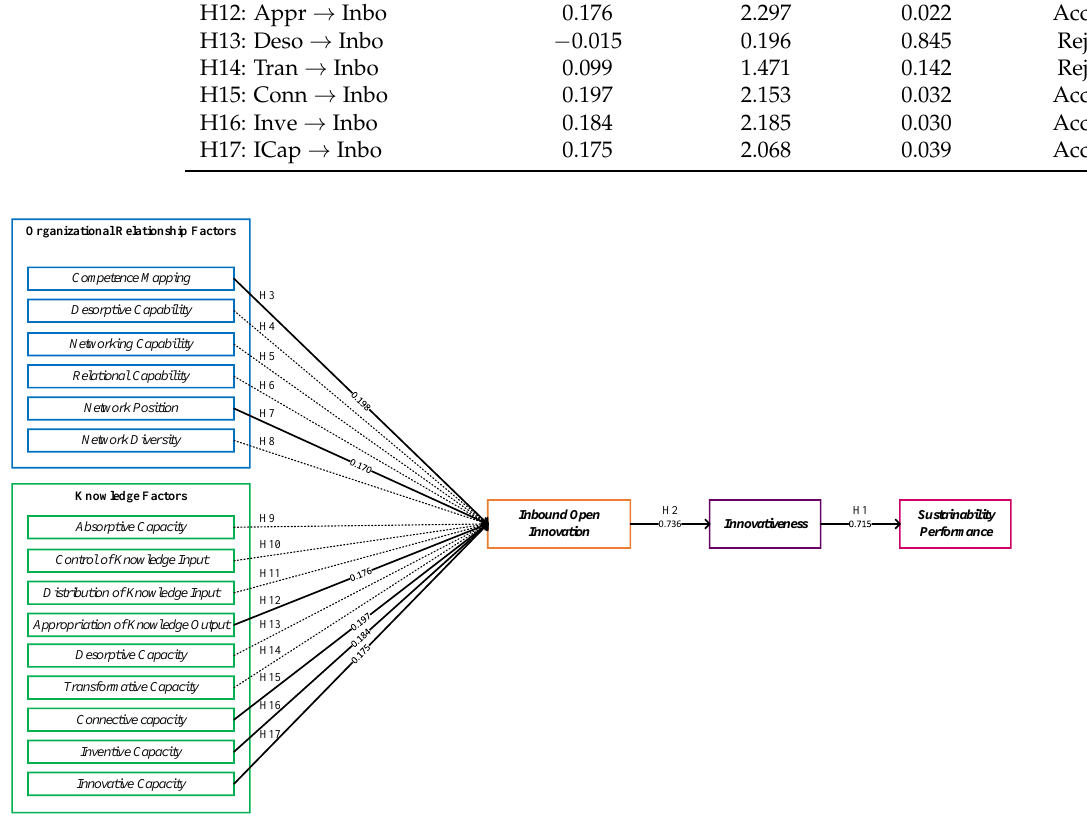
Table 4. R 2 Value.